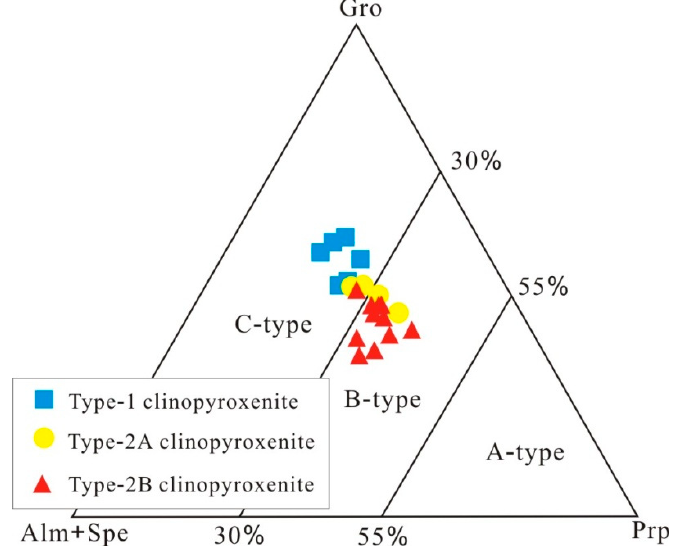
Figure 5. Composition of garnet. Three types of garnet are after Coleman et al. [33].